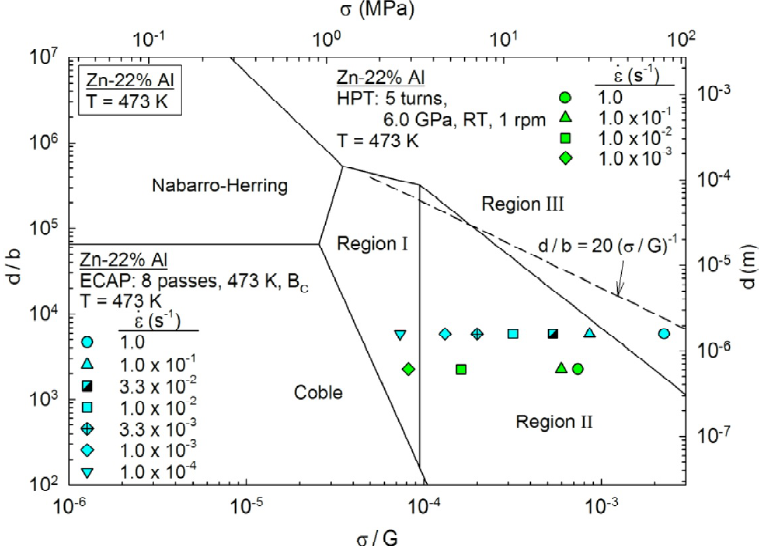
Fig. 4. A deformation mechanism map of normalized grain size versus normalized stress for a Zn-22% Al alloy tested at 473K [18]: experimental points are shown after processing by ECAP [17] and HPT [18].